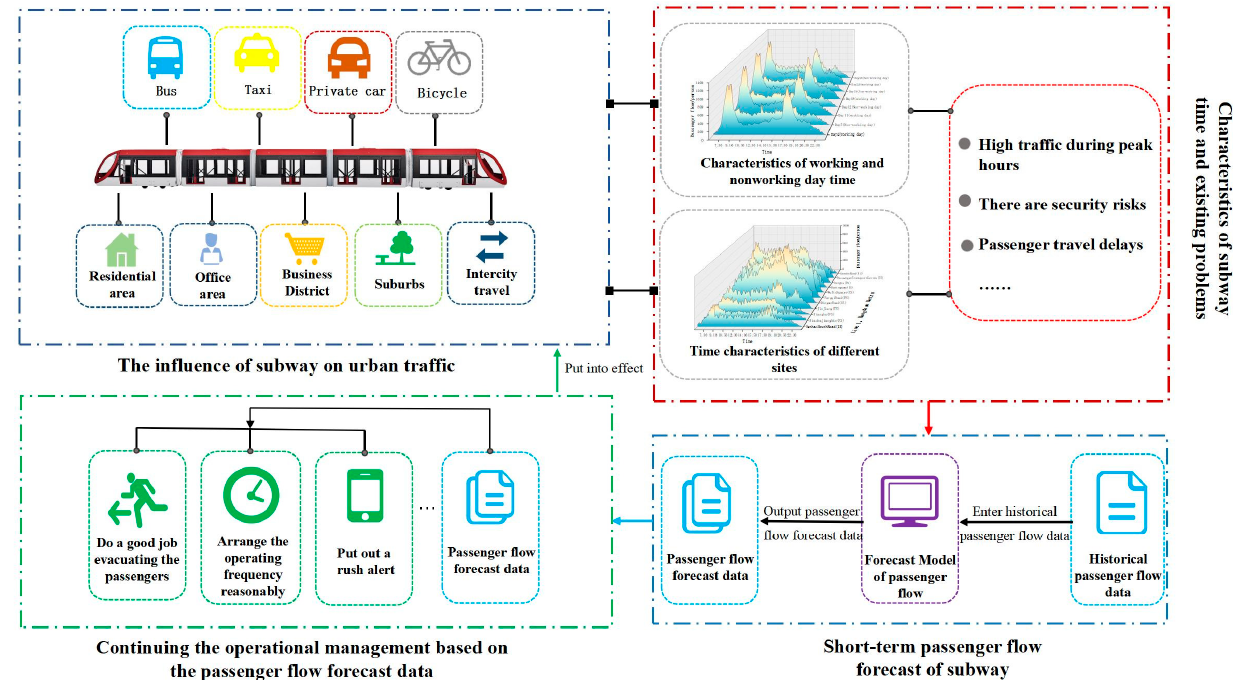
Figure 1. Frame diagram of alleviating subway passenger flow